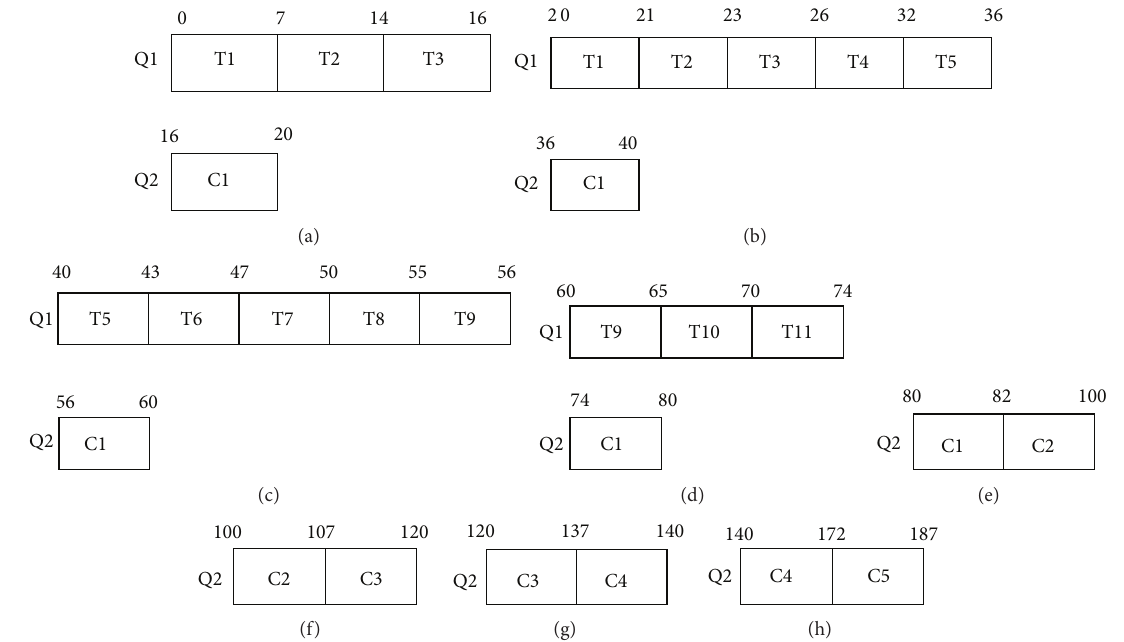
Figure 7: (a) 1st cycle of CPU (MLQ), (b) 2nd cycle of CPU (MLQ), (c) 3rd cycle of CPU (MLQ), (d) 4th cycle of CPU (MLQ), (e) 5th cycle of CPU (MLQ), (f) 6th cycle of CPU (MLQ), (g) 7th cycle of CPU (MLQ), and (h) 8th cycle of CPU (MLQ).